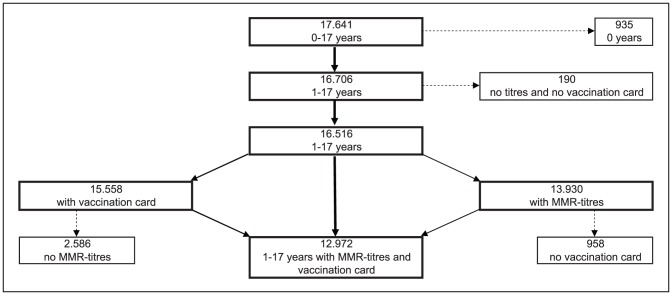
Flow chart on study subjects.